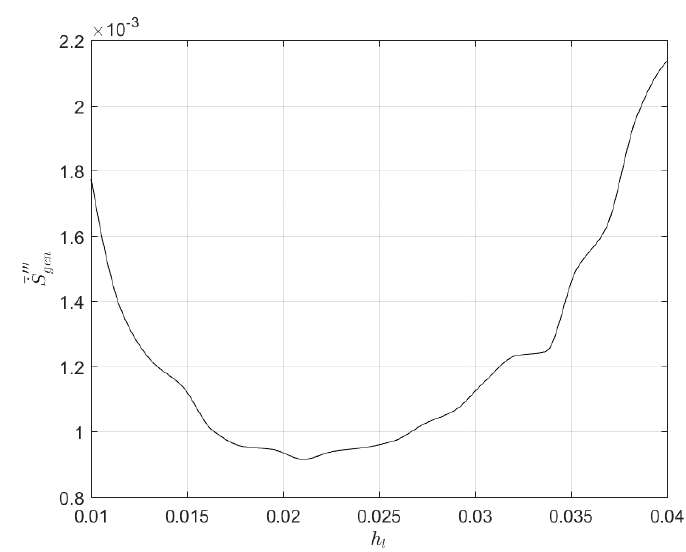
Figure 2. Generated entropy vs. the lamp distance from the bottom plate for N r = 10 and A R = 1/2. The one parameter optimization of the system is done around the condition of N = 13 (Number of heat sources), A R = 0.3 (aspect ratio is defined by height to length ratio of the cavity), N r = 1 (heating number = q ’’/ σ T ∞ 4 ), D L = 0.01 (the ratio of heat source characteristic length to length of the cavity), h L = 0.02 (the ratio of the height of heat sources from the bottom plate), and x L = 0.02 (the ratio of the gap between the heat sources to length ratio of the cavity) as shown in Figures 3–6.